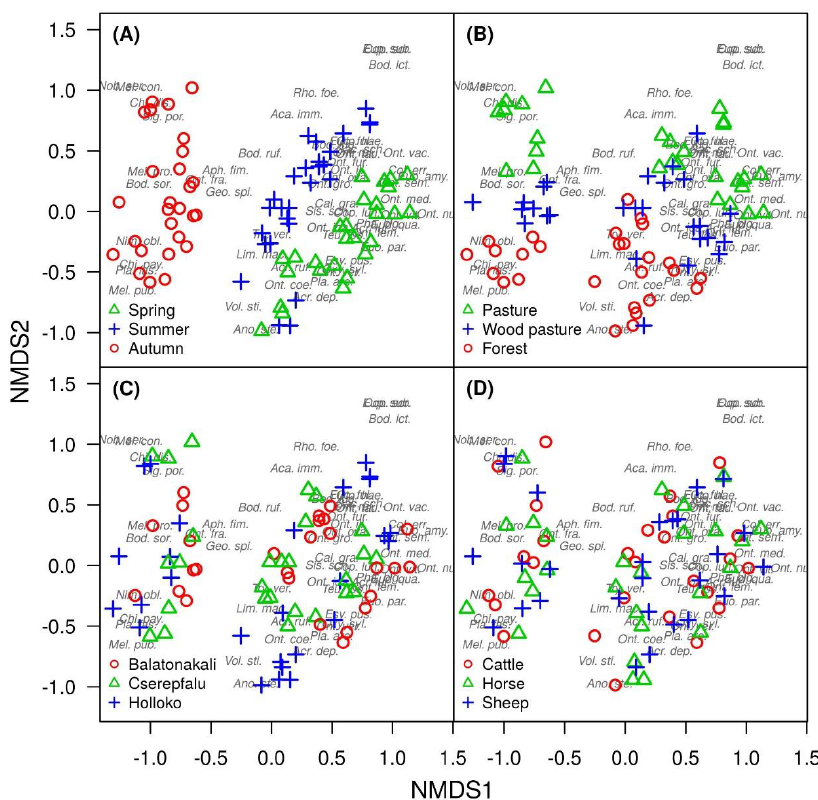
Figure 3. Assembly composition of dung beetles according to ( A ) season, ( B ) habitat, ( C ) locality, and ( D ) dung type, applying nonmetric multidimensional scaling (NMDS).